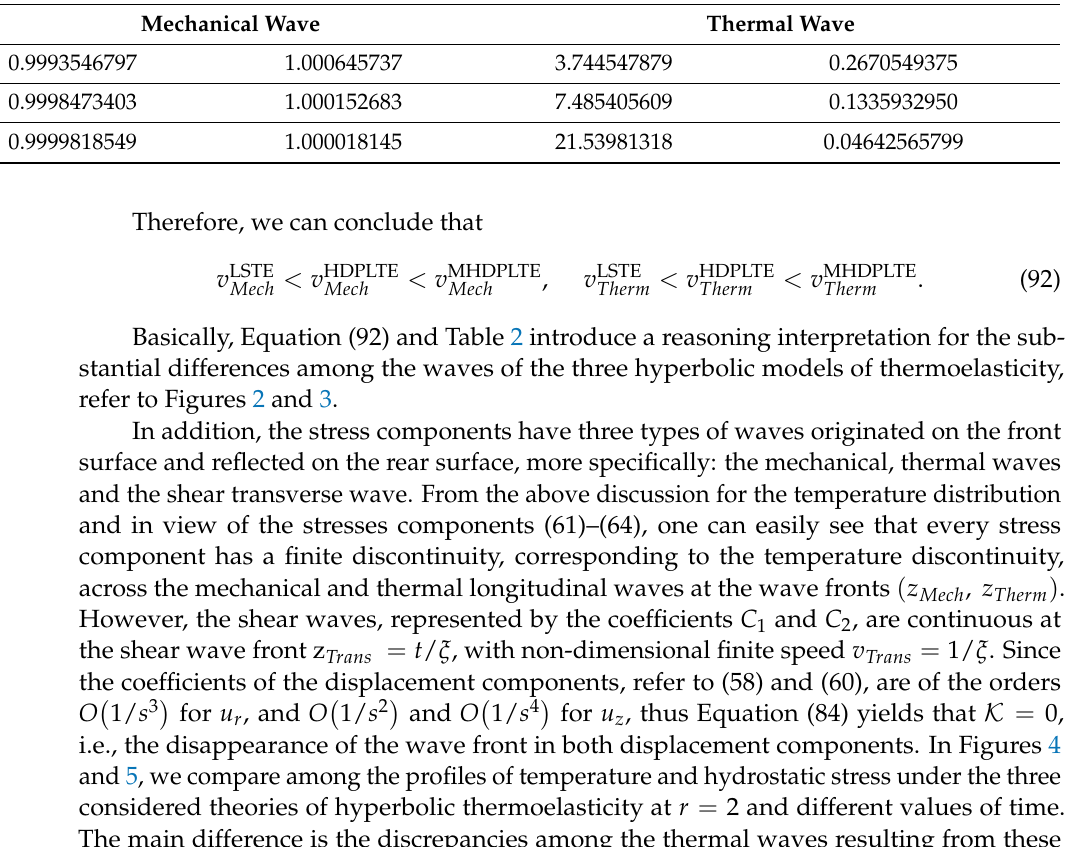
Figure 5. Comparison among the hydrostatic stress profiles resulted from the three ther- moelastic models at 𝑟 = 2 and different instants: ( a ) 𝑡 = 0.03 , ( b ) 𝑡 = 0.05 , ( c ) 𝑡 = 0.15 and ( d ) 𝑡 = 0.27 .